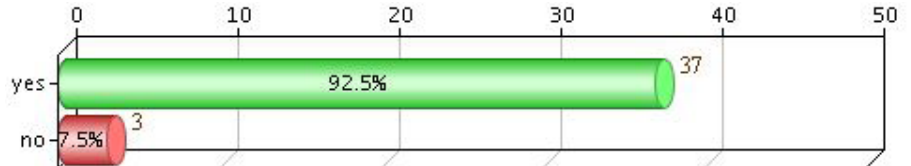
Figure 7. Did you discover new interests or new ideas from people in other areas of exper- tise than yours? ( N =